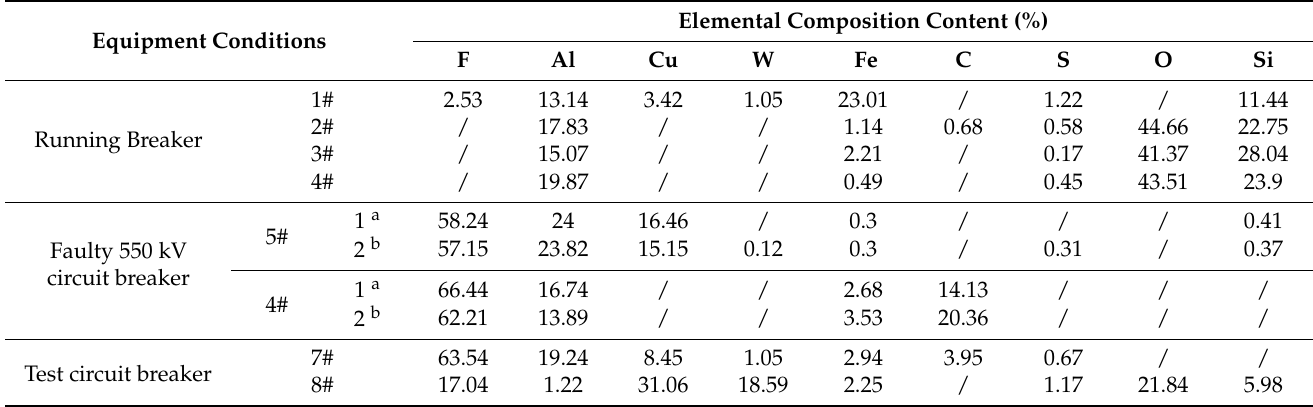
Table 8. Detection results of solid decomposition products in different circuit